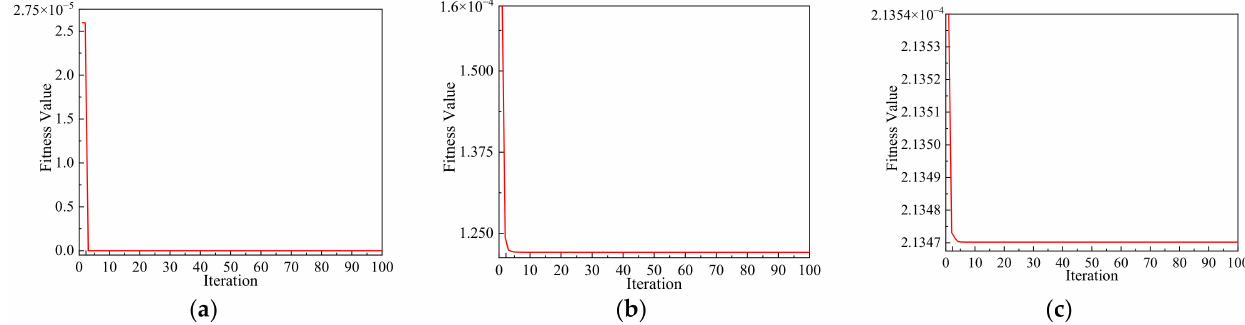
Figure 12. The iterative curves for the three-storey frame. ( a ) State 1; ( b ) State 2; and ( c ) State 3.